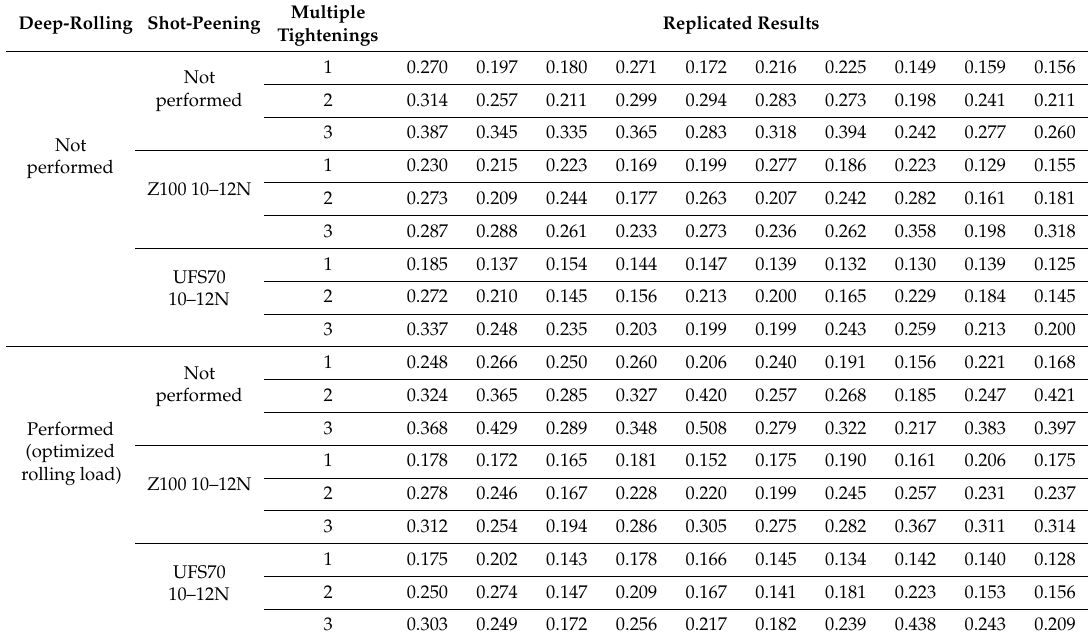
Table 4. Results in terms of total friction coe ffi cients ( µ tot ) in dry